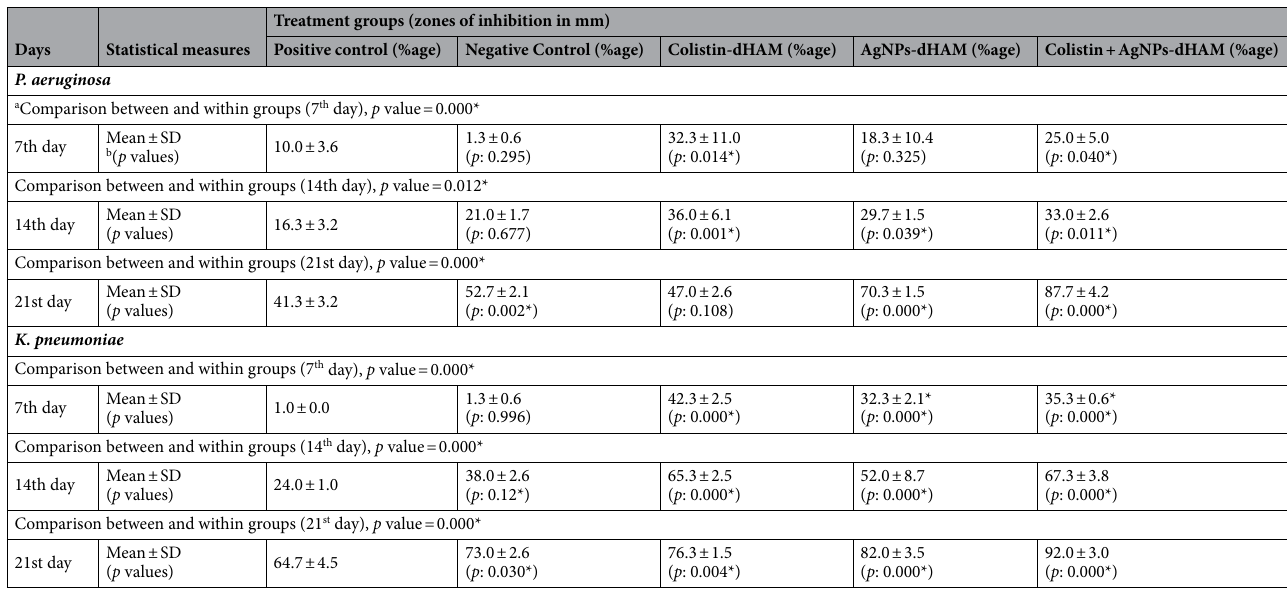
Table 4. Comparison of wound contraction in different treatment groups against P. aeruginosa and K. pneumoniae. All data are presented as mean ± SD. Superscript a. One-way ANOVA and b. Two-sided Dunnett’s test in which all other dressing groups are compared with the positive control. p < 0.05: statistically significant*